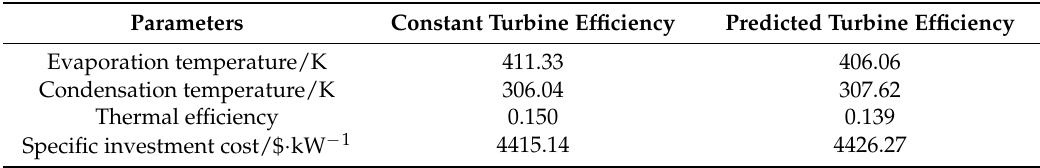
Table 1. Final optimal solution for the ORC system with different types of turbine efficiency.